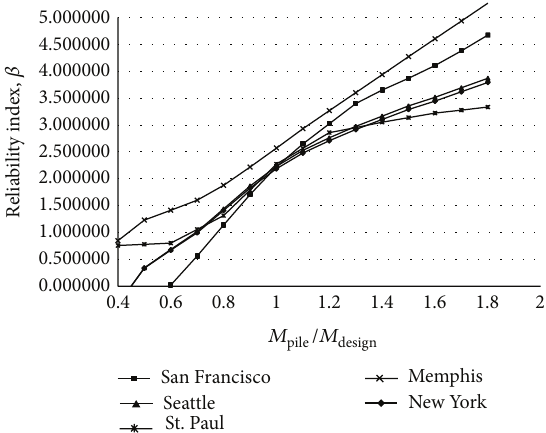
Figure 4: Reliability index for the bending of considered IAB’s pile under earthquake load alone.